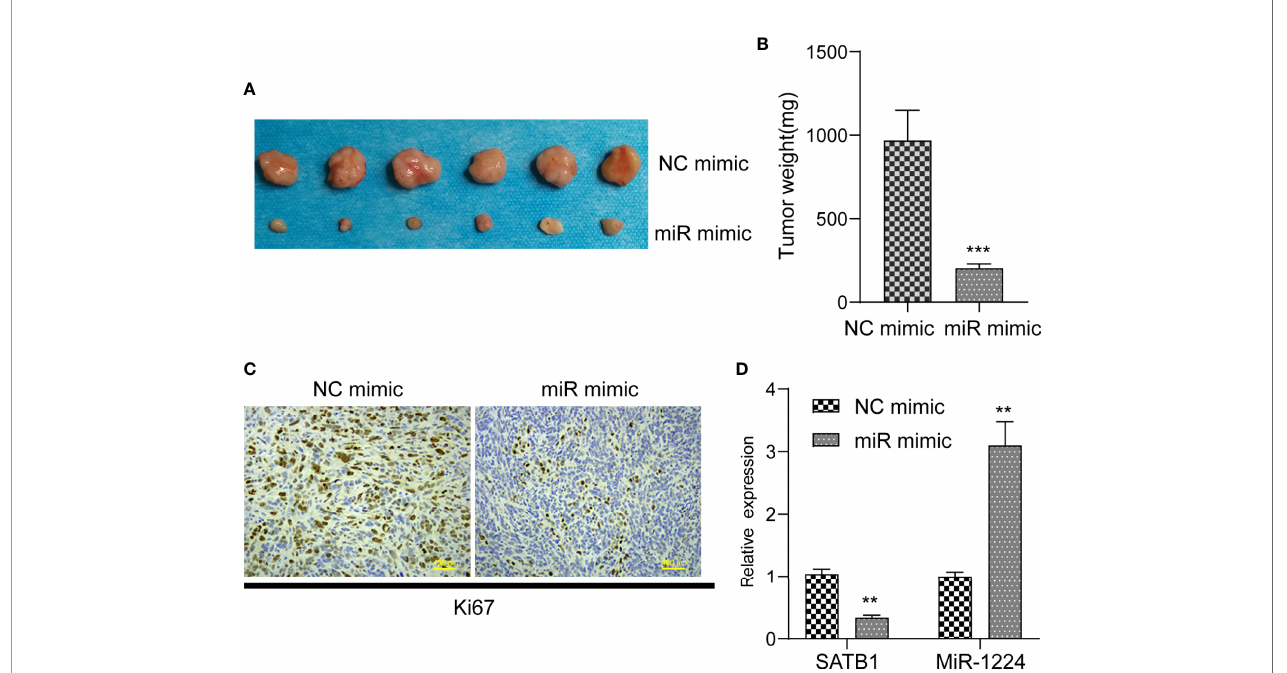
FIGURE 3 | MiR-1224 suppressed tumor growth of GC cells in vivo . (A, B) The analysis of tumor growth of miR-1224-overexpressed SGC7901 cells in the nude mice. (C) HE staining and IHC staining of Ki-67 in two groups. (D) RT-PCR assay revealed the expression of miR-1224 and STAT1 in tissues obtained from two groups. ** p < 0.01, *** p < 0.001. Experiments were repeated three times with three